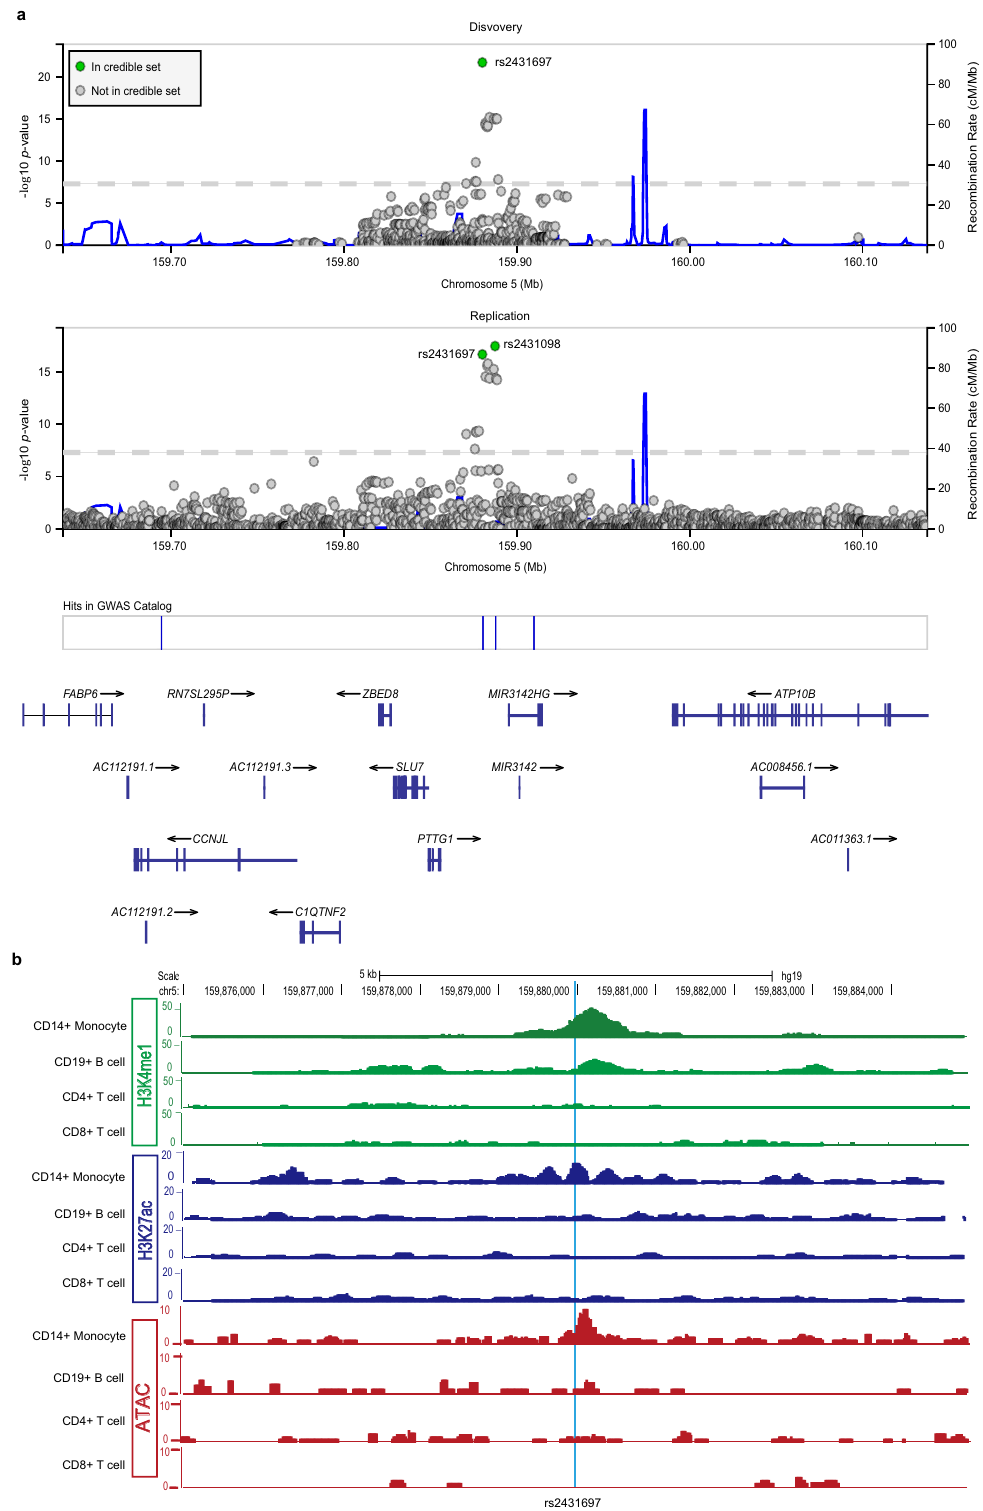
evidence of association with SLE, we fi rst conditioned on this marker in each cohort, under the assumption that this genetic association is due to a shared genetic effect across ancestries. After adjusting for rs2431697 genotype, there were variants with residual association (1E − 2 > P > 1E − 4) present in both the genotyped and imputed data (Supplementary Fig. 4). However, none of the markers were in common across ancestries. Distinct